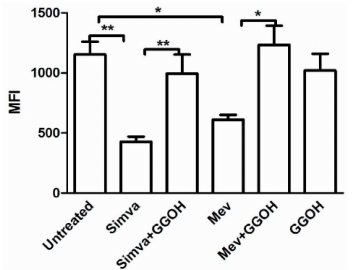
Figure 3. The Daoy cell line was incubated with Mevalonate (10 mM) and/or Simvastatin (10 µ M) for 24 h and with GGOH (50 µ M) for an additional 24 h. Bars represent the Mean Fluorescent Intensity (MFI) of Rhodamine 123 ˘ SD of five independent experiments. Data analyses were performed with one-way ANOVA and Bonferroni post-test; * p < 0.05; ** p < 0.01.